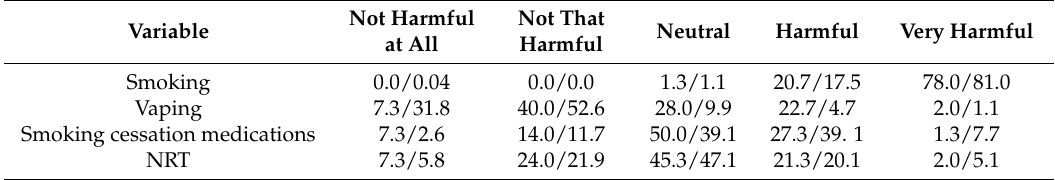
Table 4. Distributions of responses (in %) of perceived harmfulness for smoking, vaping, smoking cessation medications, and nicotine replacement therapy (NRT) for the Dutch Current/Belgian Current group. Not Harmful Not Variable at All